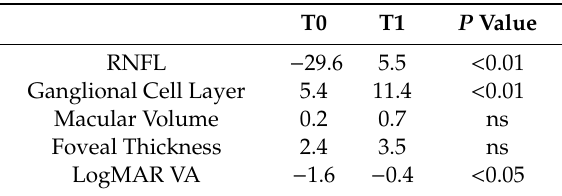
Table 4. Mean intereye di ff erences (values in nona ff ected eyes minus a ff ected eyes) in optical coherence tomography and visual function parameters in ON